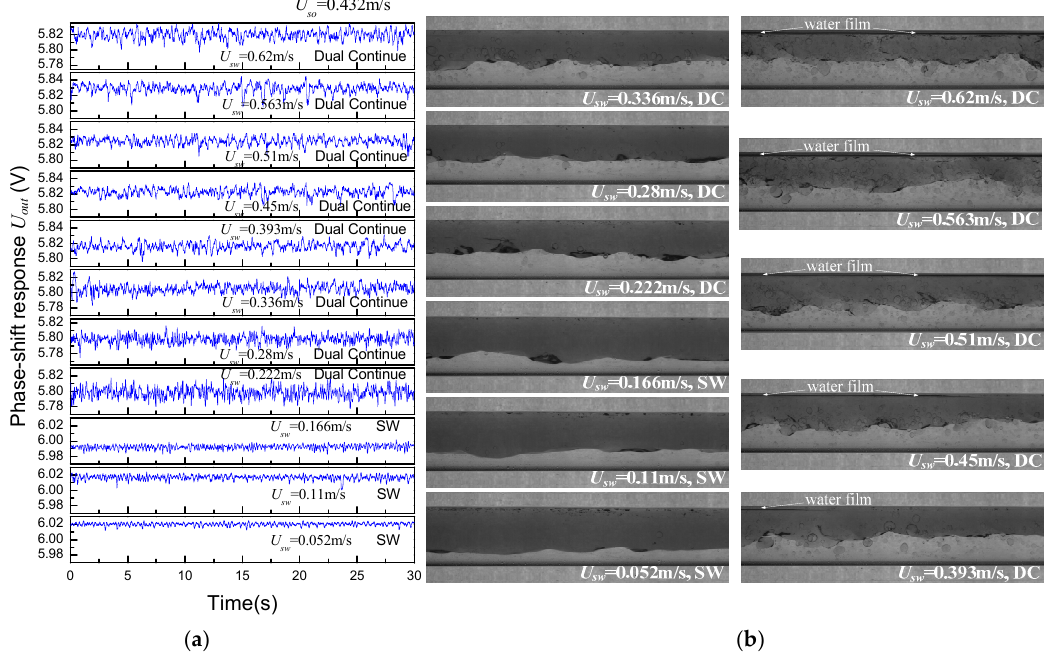
Figure 14. Phase shift response of ( a ) the CCS and ( b ) oil–water images ( U so = 0.432 m/s).